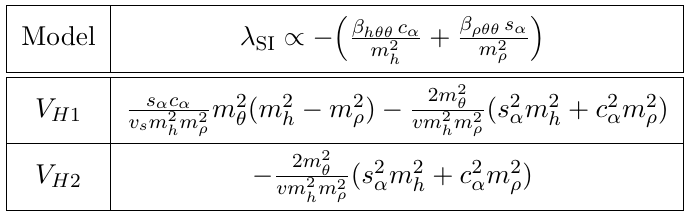
Table 5. Effective DM-nucleon coupling that enters in the DD cross section in terms of the physical parameters v, v and s s , m h , m θ , m ρ α